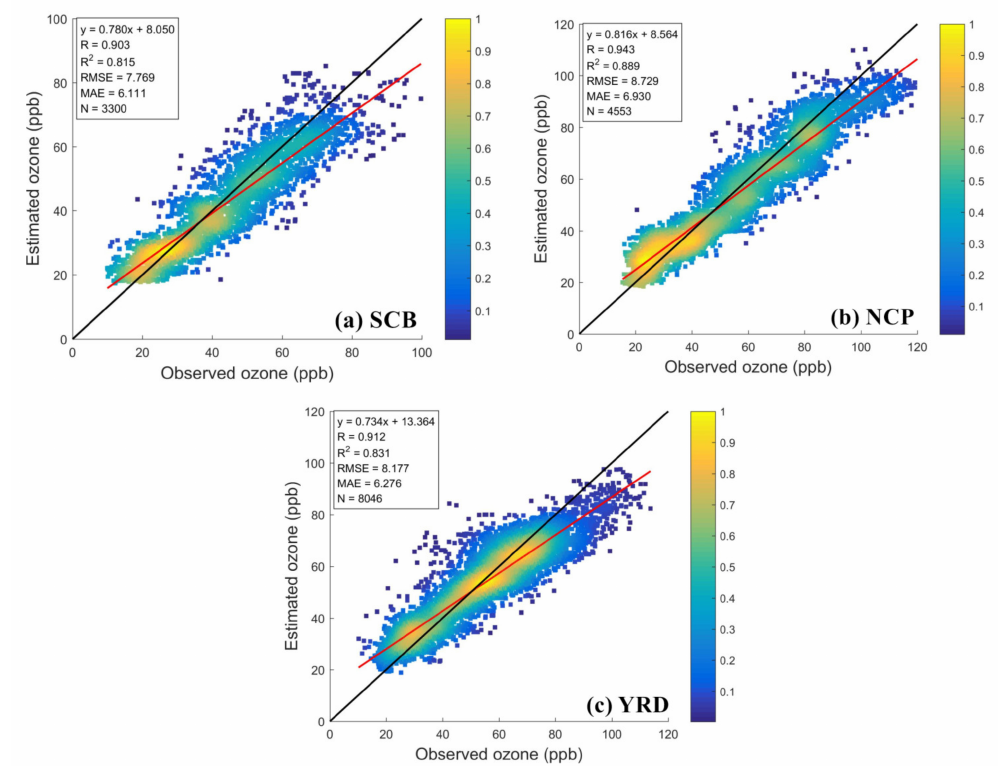
Figure 11. Validation of monthly surface ozone estimates in 2018–2019 for ( a ) SCB, ( b ) NCP, and ( c ) YRD. Statistical metrics are given in each panel, along with the linear regression relation, including the correlation of determination (R 2 ), the root mean square error (RMSE), the mean absolute error (MAE), and the number of samples